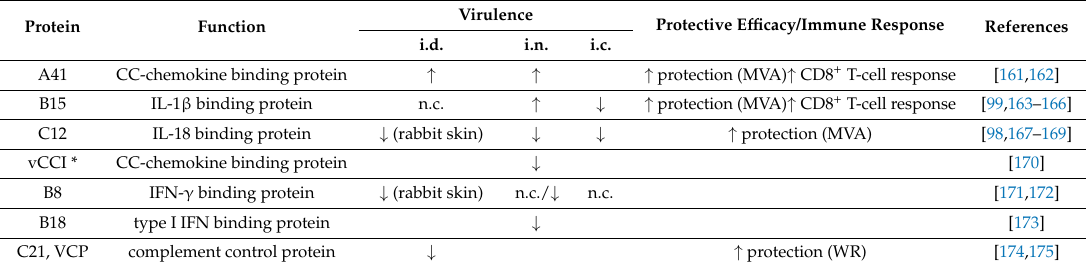
Table 2. VACV strains lacking secreted immunomodulators that have been tested for virulence and/or